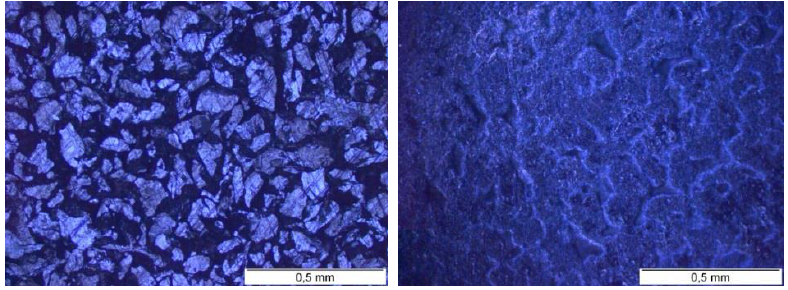
Figure 12. micrograph of non-sintered pellet at left and sintered pellet at 1300 °C at right. Figure 12. Micrograph of non-sintered pellet at left and sintered pellet at 1300 ◦ C at